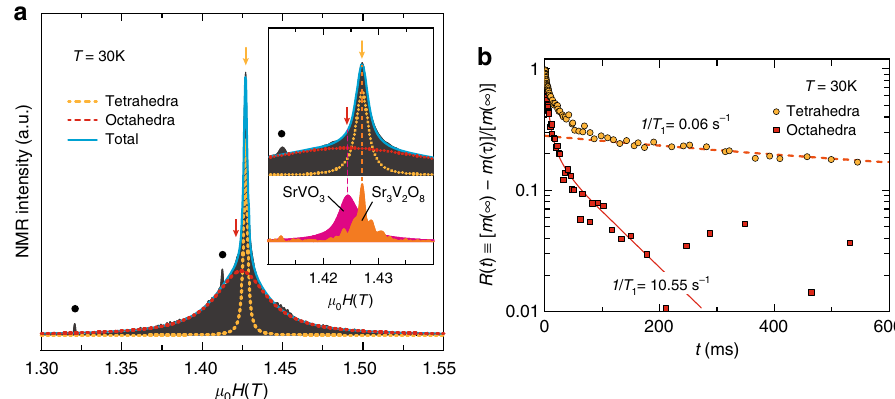
Fig. 2 51 V-NMR for 15R-SrVO 2.2 N 0.6 . a Field-swept NMR spectrum at 30 K showing peaks from tetrahedral (orange) and octahedral (red) sites. Solid circle indicates the signal from the Cu coil. The orange and red arrows indicate the positions at which 1/ T 1 was measured. Inset is an enlarged plot, where spectra of SrVO 3 and Sr 3 V 2 O 8 are shown for comparison. b Time after saturation pulse dependence of relaxation of R ( t ) ≡ [ m ( ∞ ) – m ( t )]/ m ( ∞ )], where m represents nuclear magnetization at a time t after a saturation pulse, at the tetrahedral (orange) and octahedral (red) sites. The lines are the fi t to extract the time constant. Tetrahedral data with t < 100 ms were not considered due to octahedral-site contribution (see yellow arrow in a ).